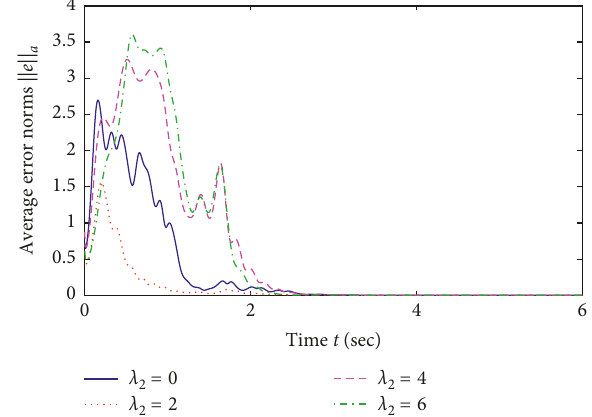
Figure 5: Time evolution of the average error norms e different tempered parameters λ